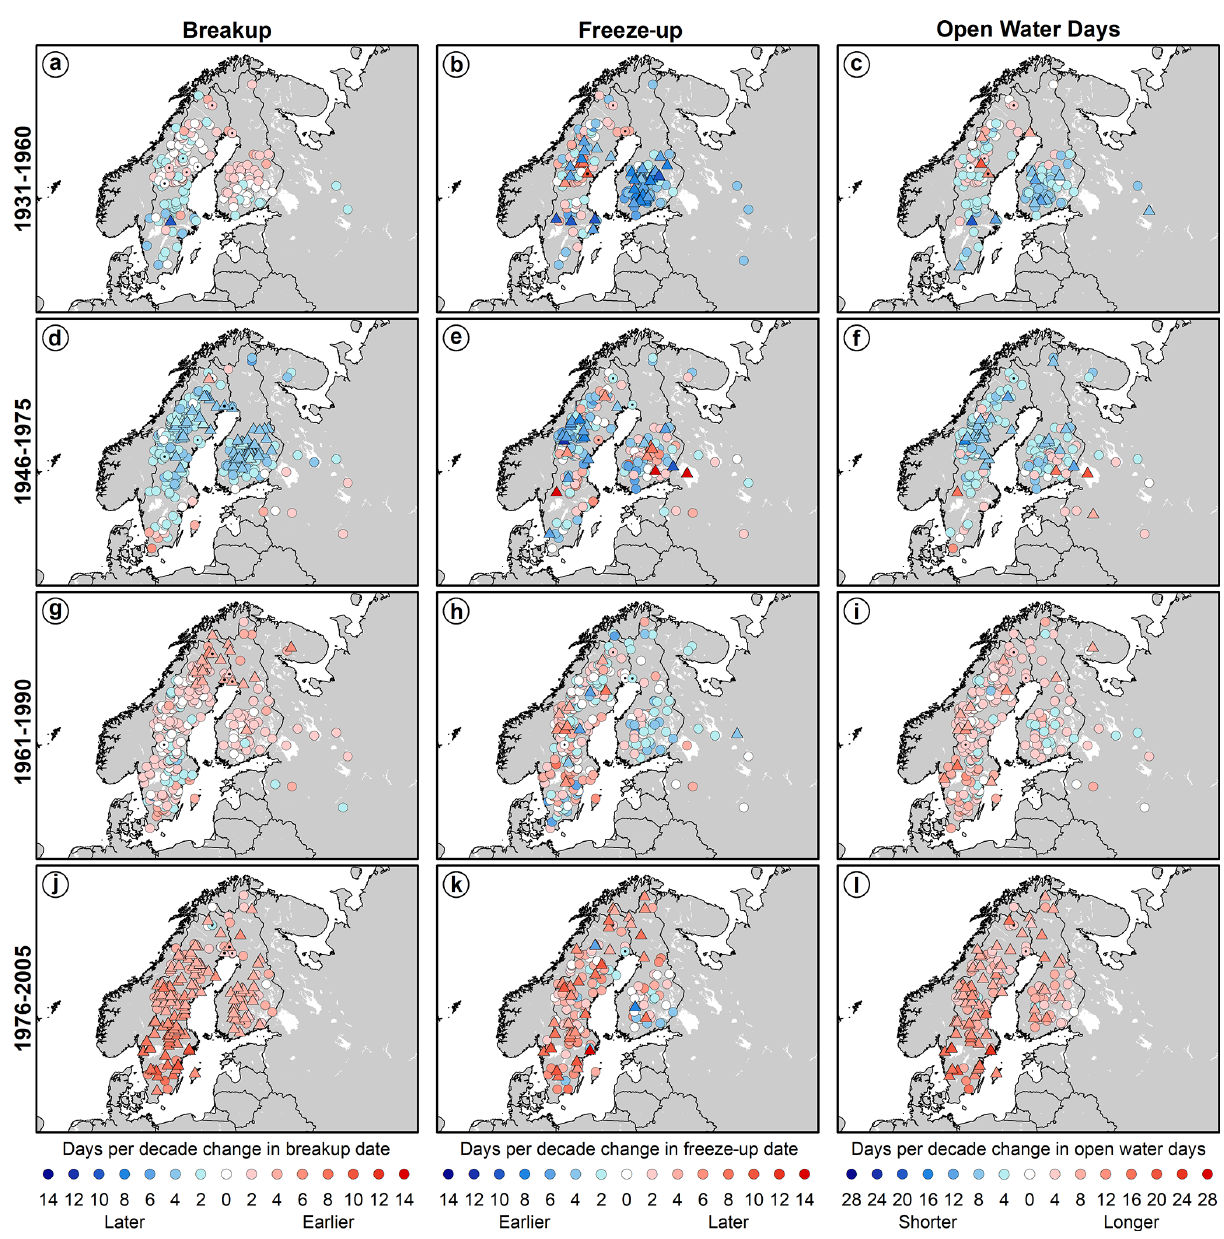
Figure 5. Decadal trends for breakup (a, d, g, j) , freeze-up (b, e, h, k) , and the number of annual open-water days (c, f, i, l) in Europe for the four individual time periods. The trend directions and magnitudes were derived from the Mann–Kendall and Sen’s slope tests. The triangles and circles indicate whether the trend was or was not statistically significant. Sites with a dot in the centre of the circle are river sites. Thus, a red triangle symbol with a dot in the middle indicates a river site that has a statistically significant warming trend over that time period. The blue and red tones on the scales are related to cooling and warming trends, respectively. Note that in some places the symbols overlap.